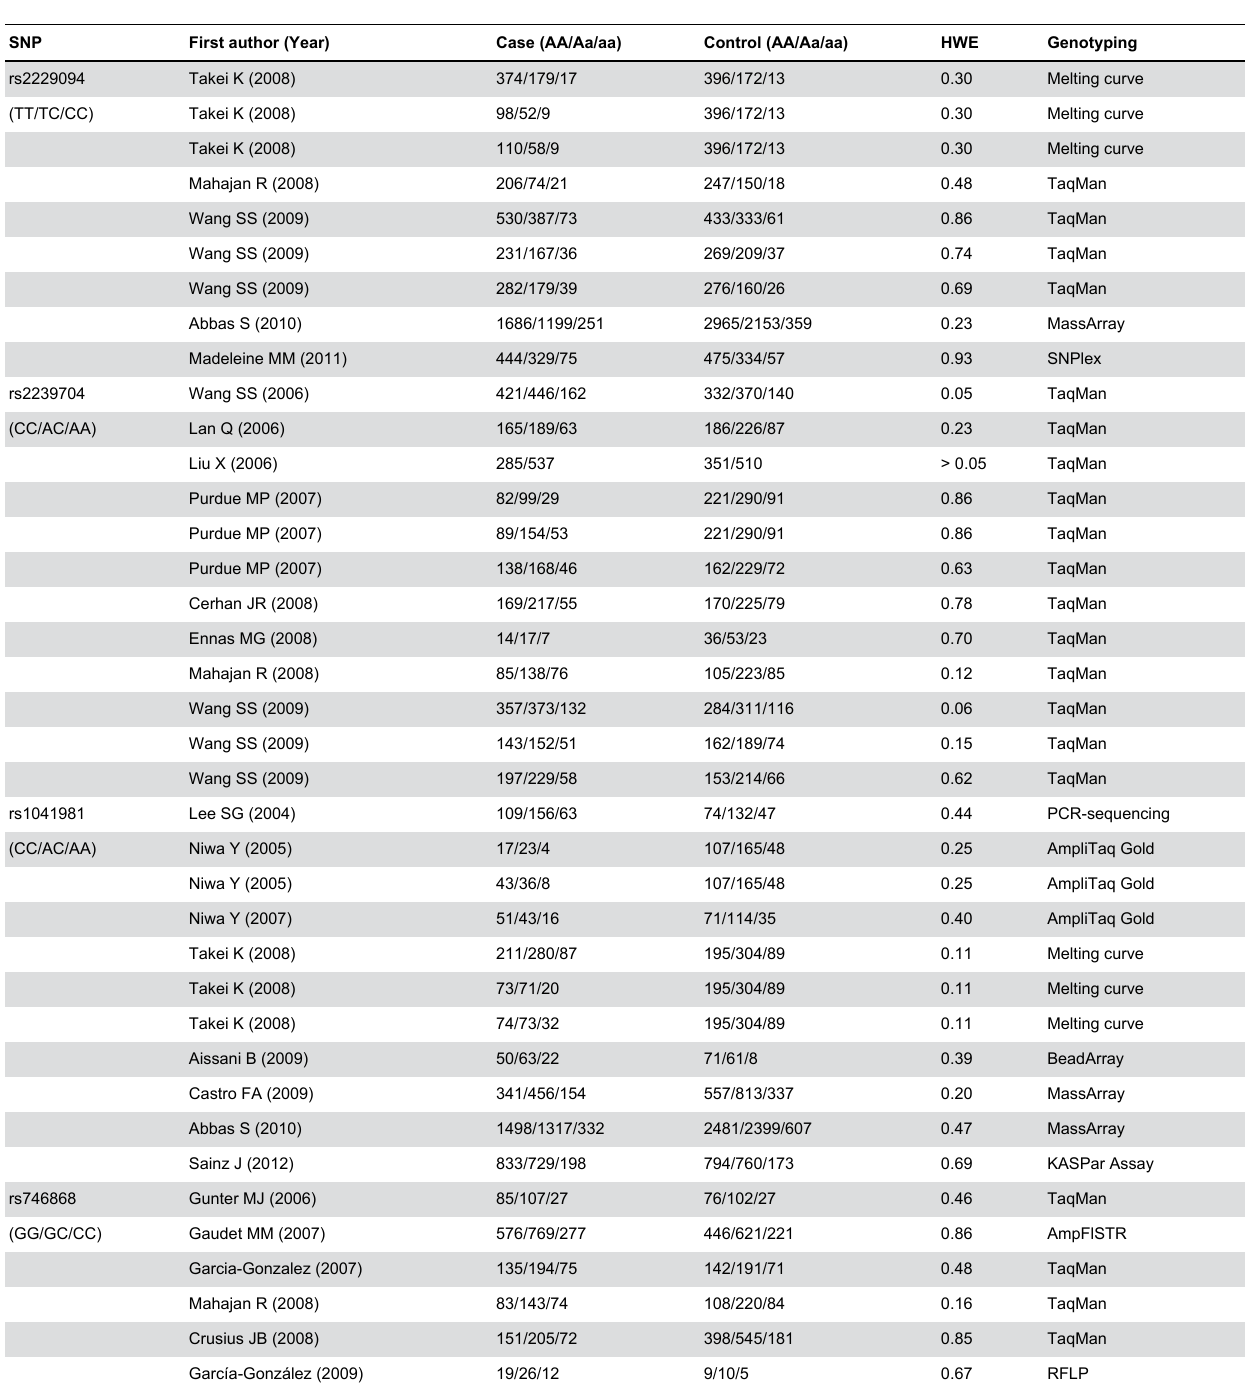
c: The results of Jacobs EJ et al (2008) are not listed in the table because they only proved the A allele frequency. The study of Liu X et al (2006) only proves the number of